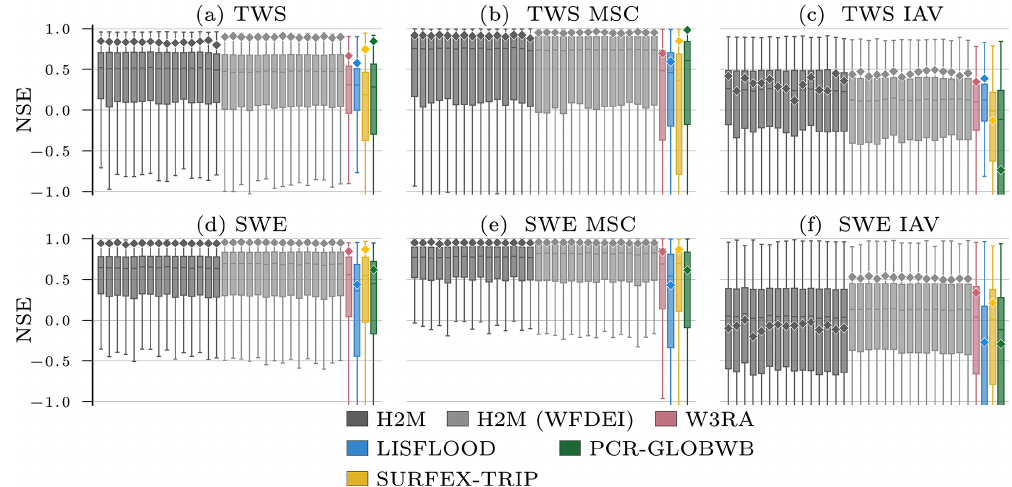
Figure D1. Global and local grid cell level Nash–Sutcliffe model efficiency coefficient (NSE) of the hybrid hydrological model (H2M) and the process-based global hydrological models (GHMs) for the terrestrial water storage (TWS) on top and the snow water equivalent (SWE) at the bottom. The gray bars represent the cross-validation runs using the forcings described in Sect. 2.1.1 (dark gray; H2M), and using the WFDEI forcings as used in the eartH2Observe ensemble (light gray; H2M (WFDEI)). The (cid:5) markers show the global (spatially averaged signal) model performance, and the boxes represent the spatial variability in the local cell-level performance. The y axis was cut at − 1 due to some large negative NSE values. The panels show the model performance in respect to the full time series, the mean seasonal cycle (MSC), and the interannual variability (IAV). Note that, for SWE, only grid cells with at least 1d of snow are shown, as the NSE is not defined if the observations are constant zero, which would lead to a comparison of different grid cells. The metrics are calculated from the complete common time range from 2009 to 2012 on monthly timescale. Note that deviations from the numbers reported in Table 3 are due to different time